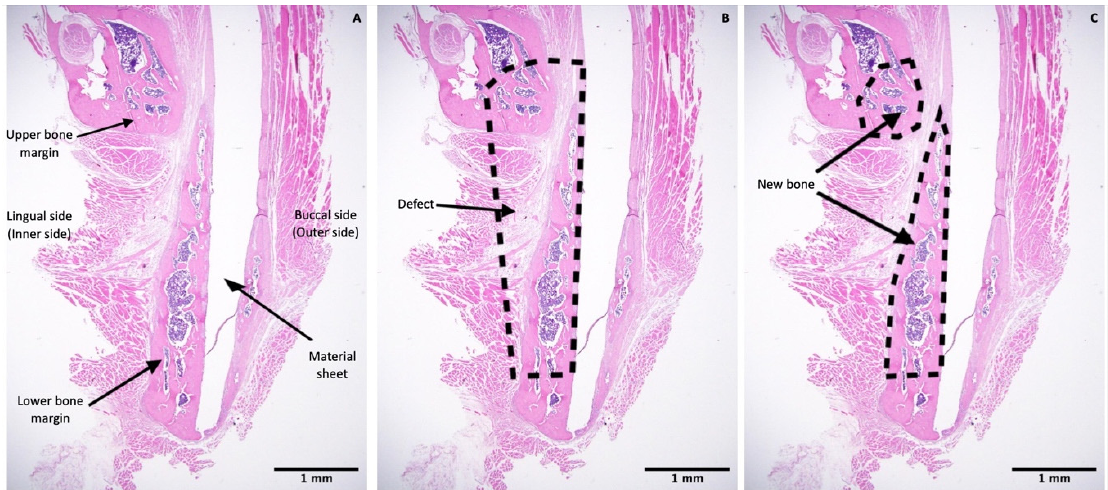
Figure 4. Histomorphometric evaluation. ( A ) Image at 1.25× magnification including the upper and lower bony margins of the defect region and the sheet covering the defect. ( B ) Illustration of the whole defect region. ( C ) Illustration of the new bone area in upper and lower bony margins. Scale bars: 1 mm (Black).